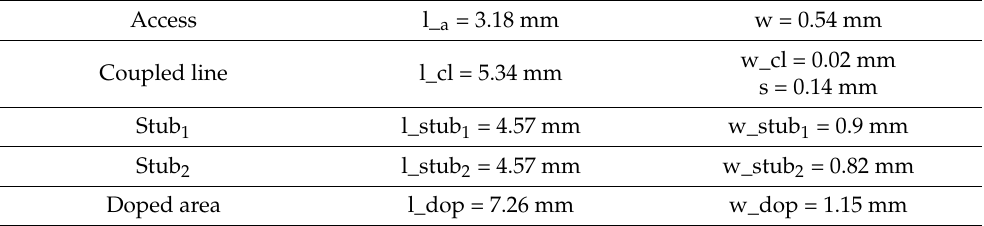
Table 4. Dimensions of the 5 GHz reconfigurable